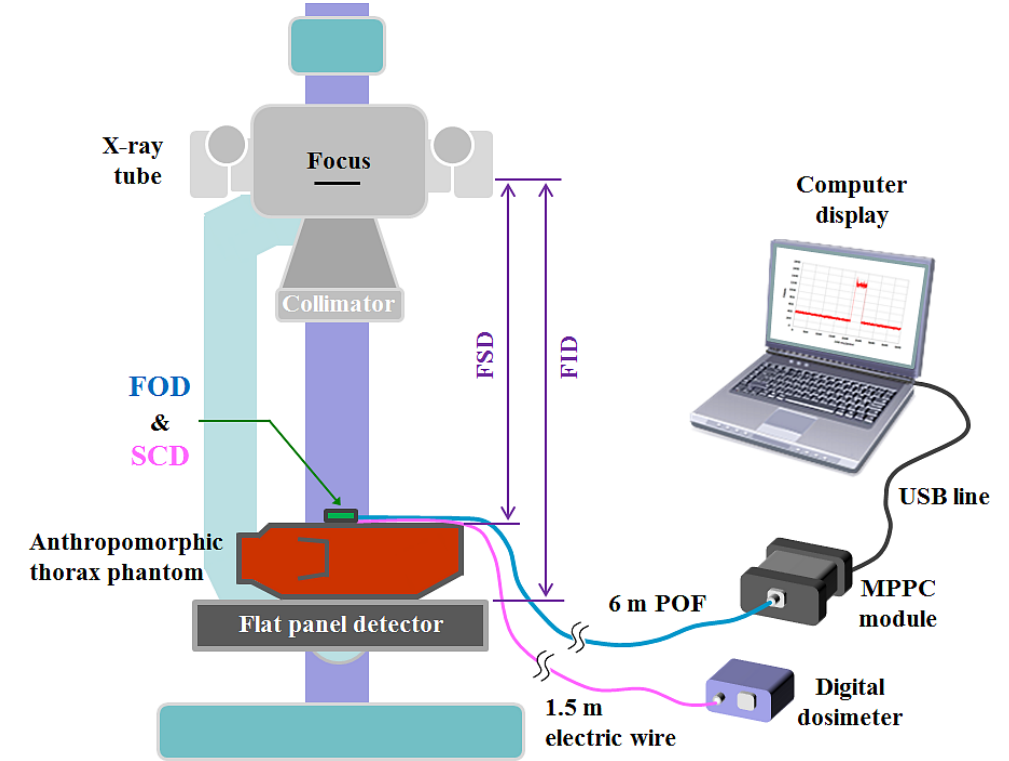
Figure 2. Experimental setup for measuring ESDs on the anthropomorphic thorax phantom in a DR